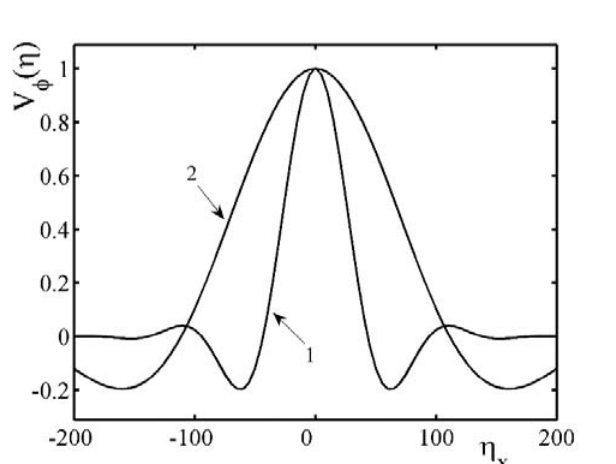
Figure 2: Normalized correlation function versus for the extraordinary (curve 1) and the ordinary (curve 2) electromagnetic